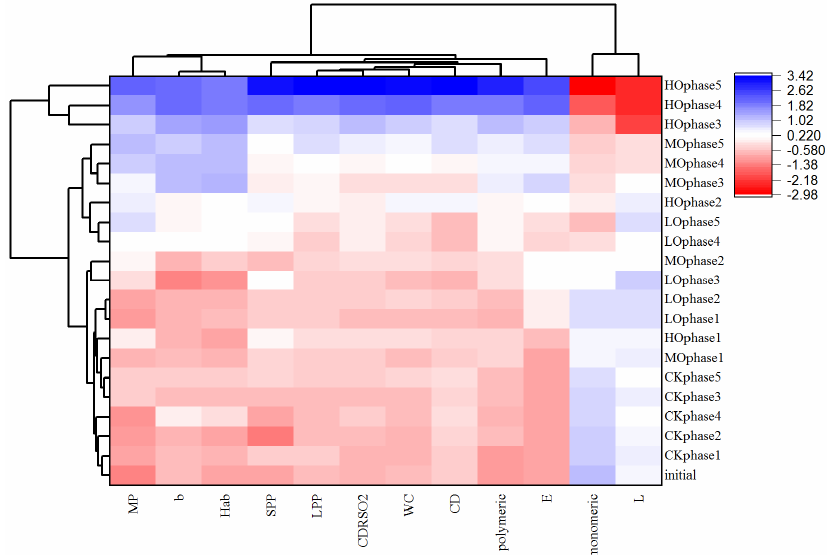
Figure 5. Clustered heatmap of the evolution of selected chemical parameters during the oxygenation cycles. Abbreviations: initial, initial wine before oxidation treatment; CK, anaerobic wine (0 mg O 2 /L per time); LO, low-level oxygenation wine (0.5–0.9 mg O 2 /L per time); MO, medium-level oxygenation wine (1–1.9 mg O 2 /L per time); HO, high-level oxygenation wine (3–3.9 mg O 2 /L per time); MP, monomeric pigments; SPP, small polymeric pigments; LPP, large polymeric pigments; WC, total color of free anthocyanins and anthocyanins eventually involved in bisulfite adducts; CDRSO 2 , color due to derivatives resistant to SO 2 bleaching; CD, color density; polymeric, polymeric anthocyanins; monomeric, monomeric anthocyanins; co-pigmented, co-pigmented anthocyanins.